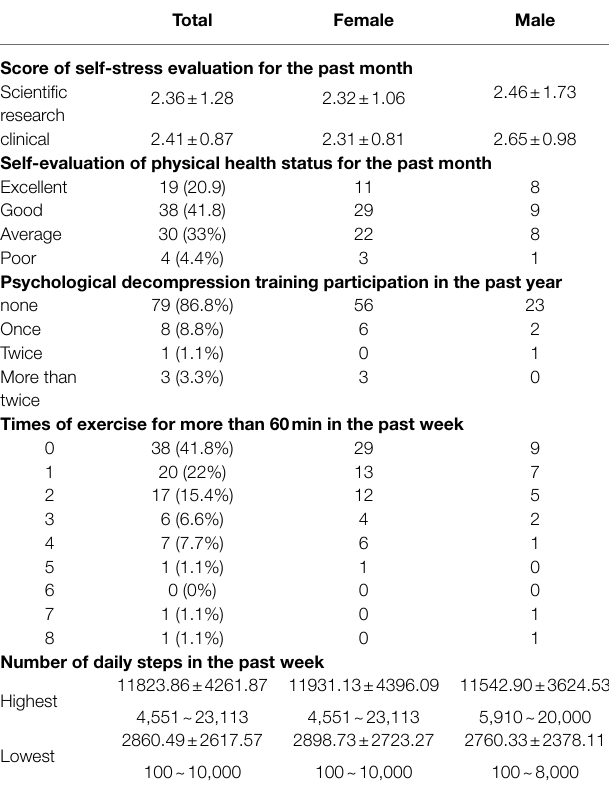
TABLE 4 | Maslach Burnout Inventory subscale scores according to sociodemographic variables.